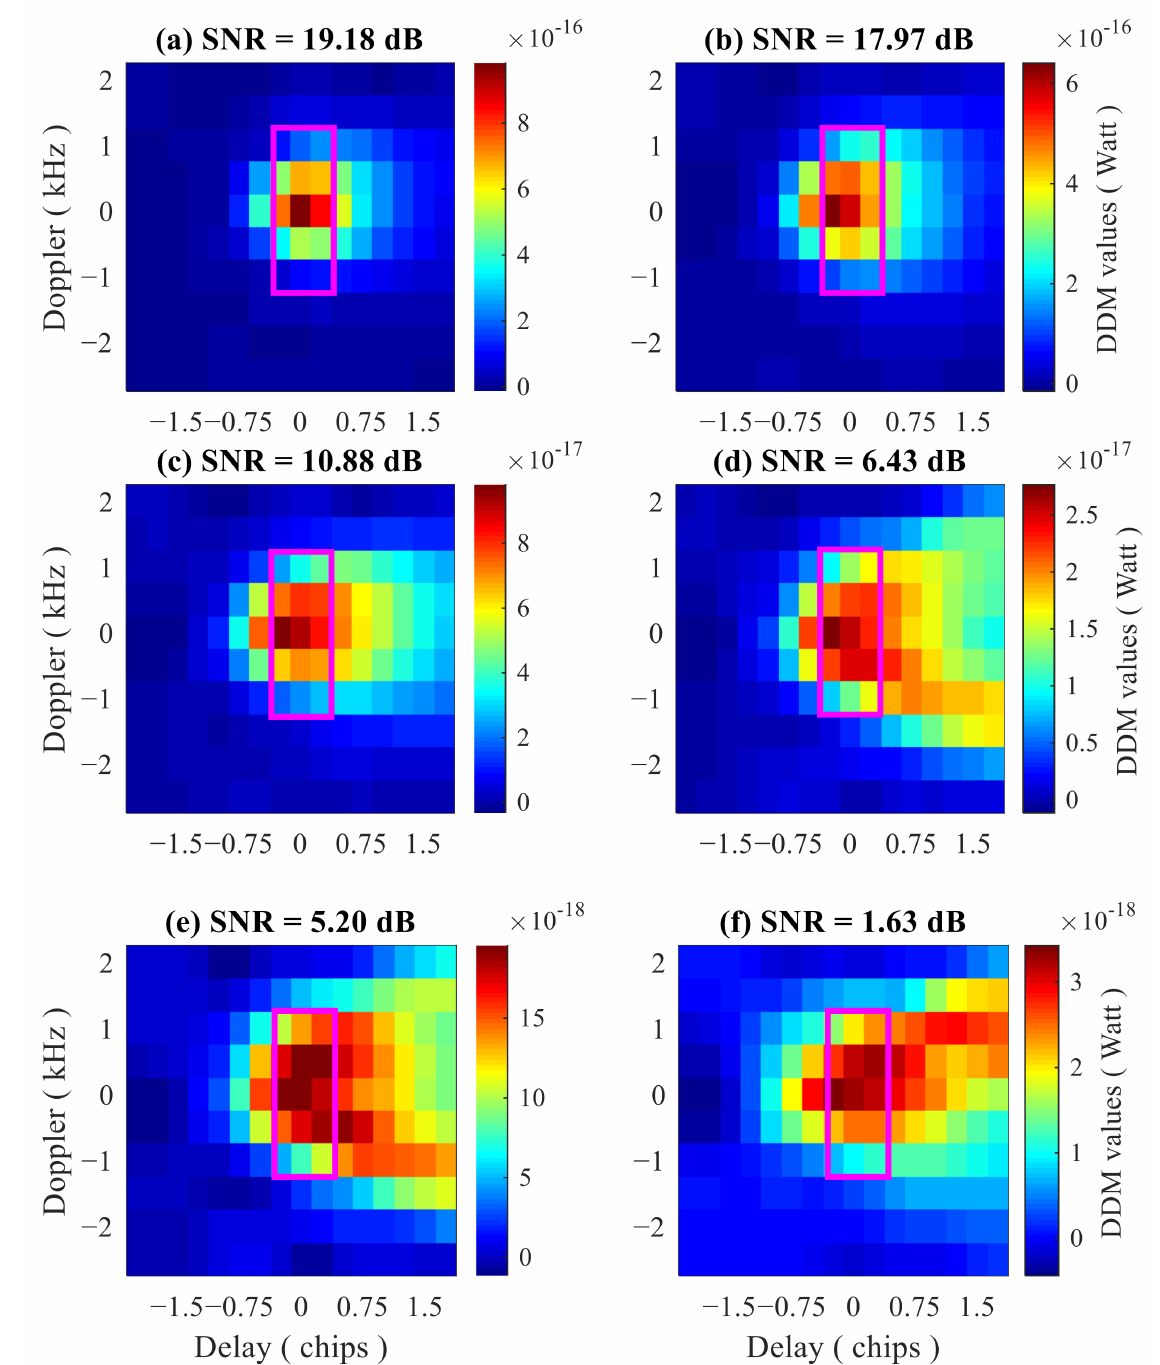
Figure 2. DDMs with different SNR. The swell heights corresponding to each DDM are 0.316 m ( a ), 0.881 m ( b ), 1.633 m ( c ), 2.686 m ( d ), 3.408 m ( e ), and 5.218 m ( f ),